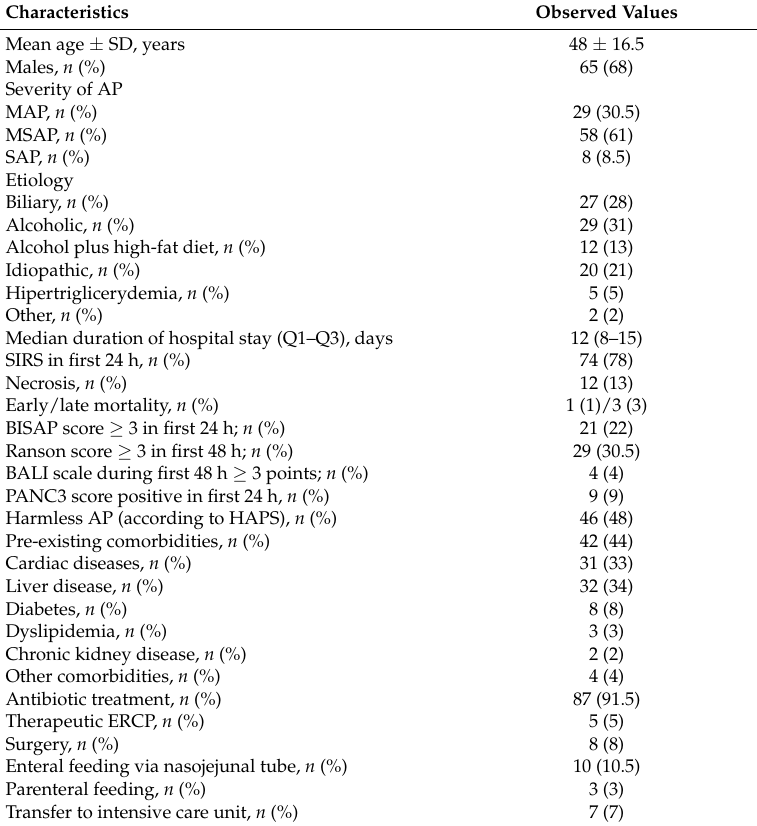
Table 1. Clinical characteristics of the study group of 95 patients with